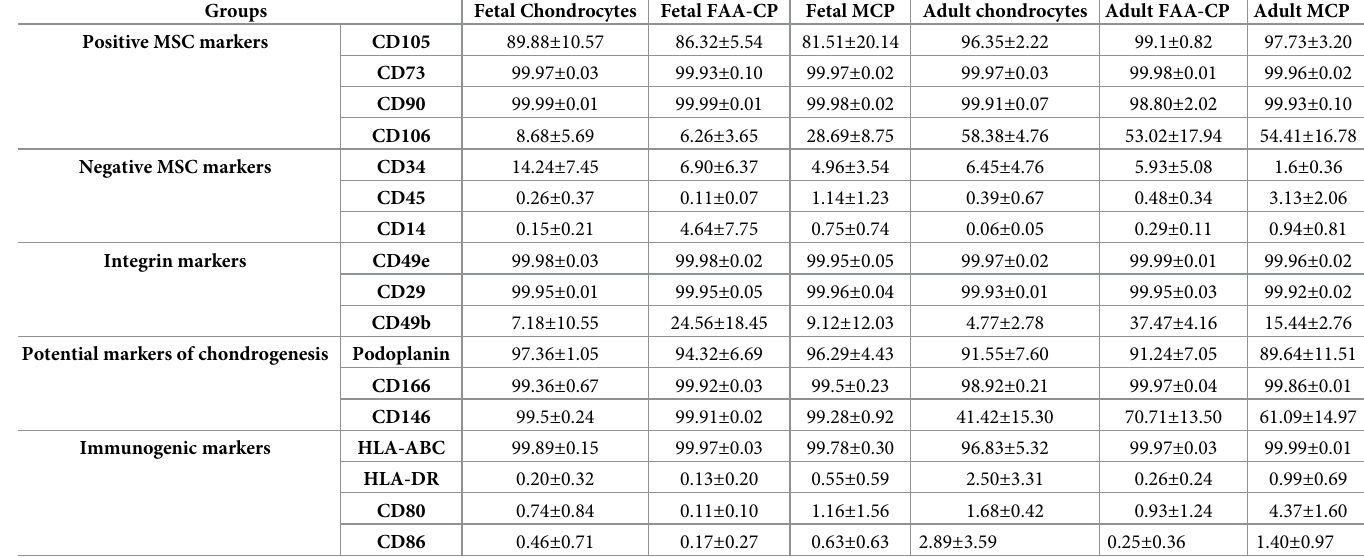
Table 1. Fluorescence-activated cell sorting data. The groups included: Positive and negative MSC markers, potential markers of enhanced chondrogenesis, and immu- nogenic markers of the six cell groups. Data is expressed as percentage mean ± Standard Deviation (n = 3).